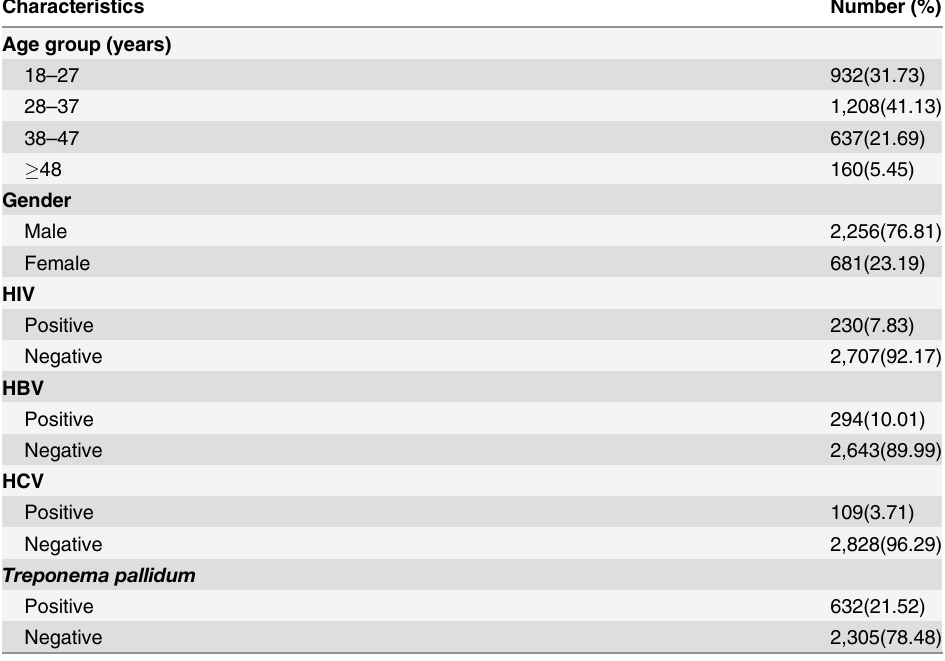
Table 1. The socio-demographic characteristics of blood donors from the Malabo Regional Hospital on Bioko Island, Equatorial Guinea, 2011 – 2013. Characteristics